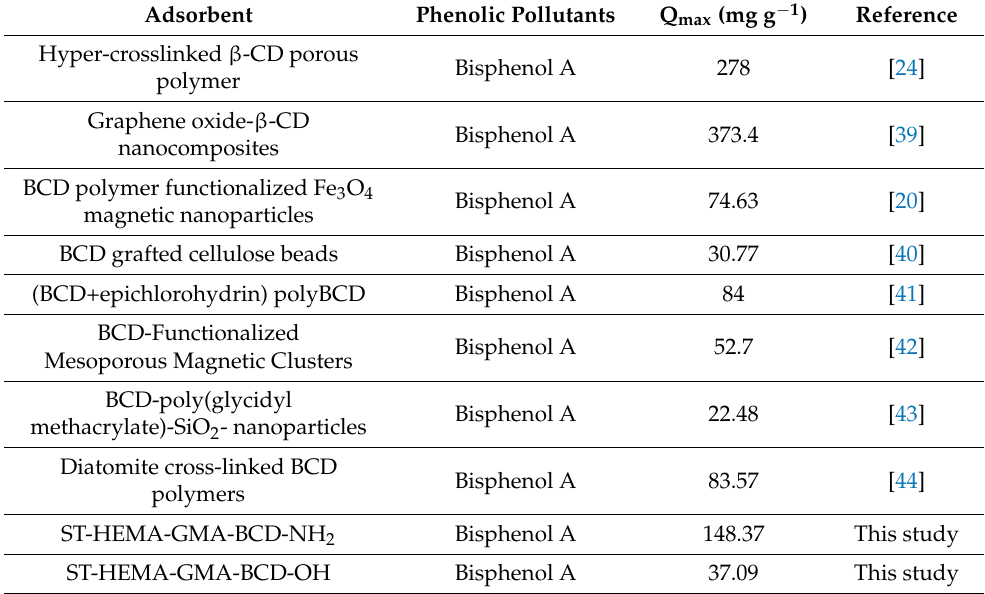
Table 3. Comparison of adsorption capacities of different polymer adsorbents for bisphenol A.